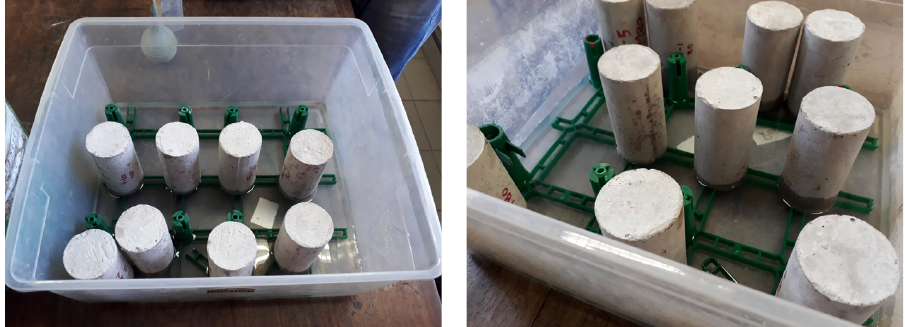
Figure 2. Immersion in water of the specimens for measuring capillary water absorption coefficients of mortars MNS and MHS.